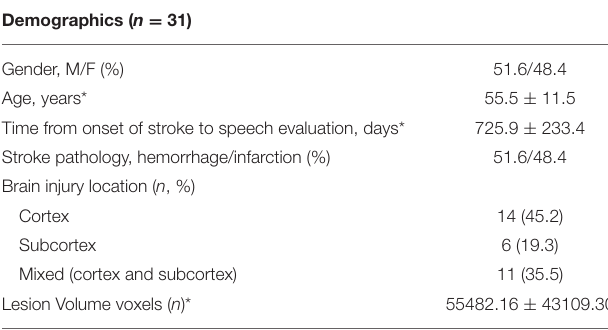
TABLE 1 | Patient demographic and clinical